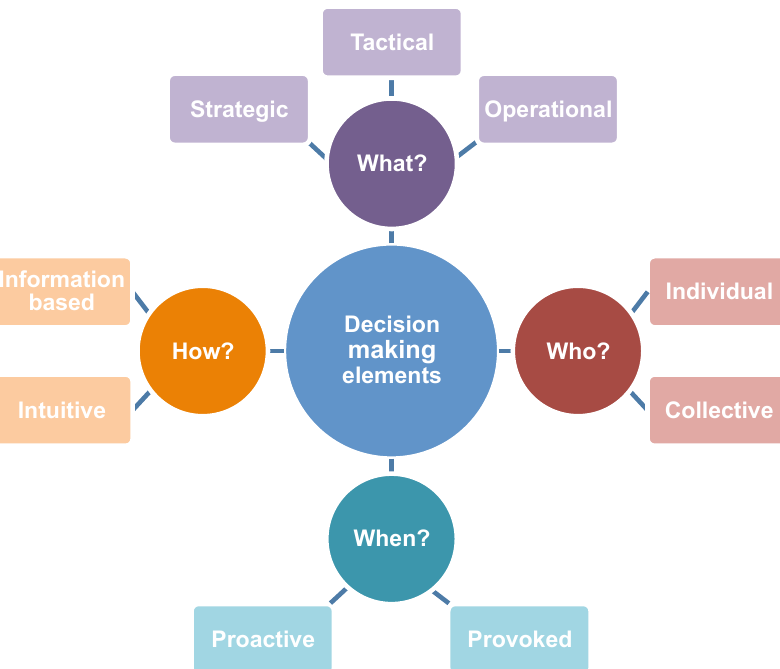
Figure 7. Diagram of the four key decision-making elements: What? When? How? Who? Different decision-making mecha - nisms emerge based on the combinations of options around each of the four elements (modified from Bowett,